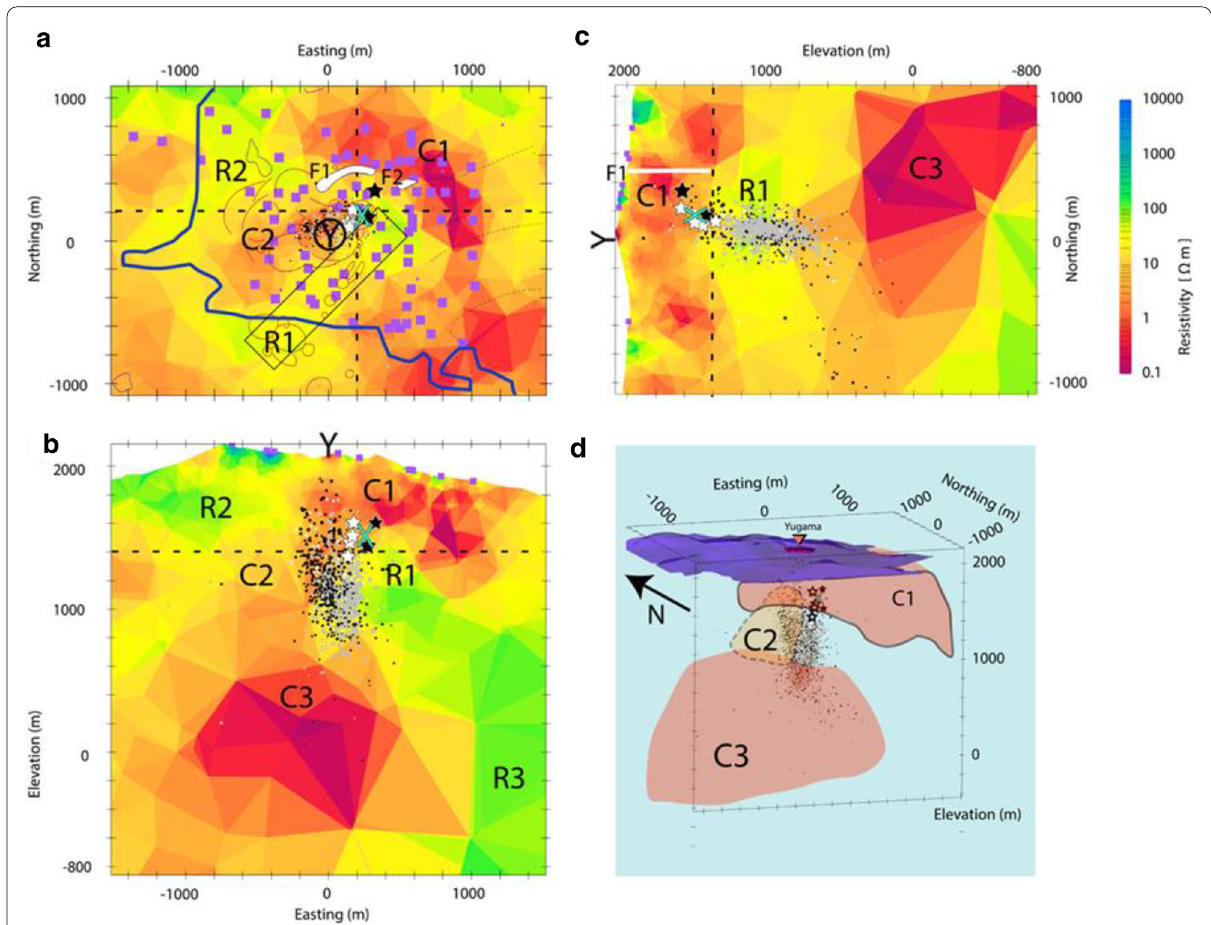
Fig. 4 a Depth slice at 1400 m ASL. The locations for W–E and S–N profiles for sections are shown by broken lines. b W–E and c S–N sections. The seismic hypocenters are mapped as dots on each map within 200 m tolerance normal to the sections. The white, black, and gray dots denote hypocenters before, during and after the 2014 unrest, respectively. The shallow seismicity (black dots) going through the clay cap (C1) is evident during the 2014 unrest. The white and black stars denote the same as in Fig. 3. The blue X denotes the point pressure source locations for explaining the radial infation of the edifce during the 2014 unrest (Terada et al. 2015). Two white masks with irregular shape in a denote the fumarole zone at the north of Yugama crater lake. The white line in c denotes the projection of fumarole zone F1 at 1400 m ASL. d The 3-D view of the three major conductors. The blue surface shows the topography. The dots denote seismicity as in a –